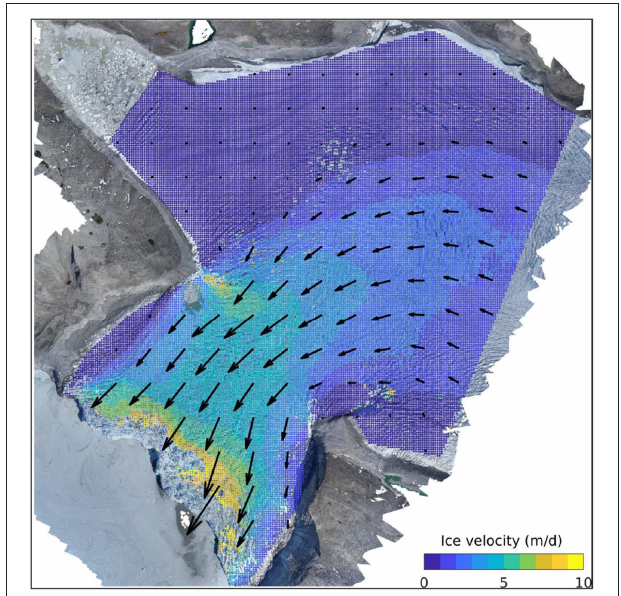
FIGURE 7 | Three days separation horizontal ice flow velocity field of Eqip Sermia glacier obtained from the large-scale surveys performed on July 8 and